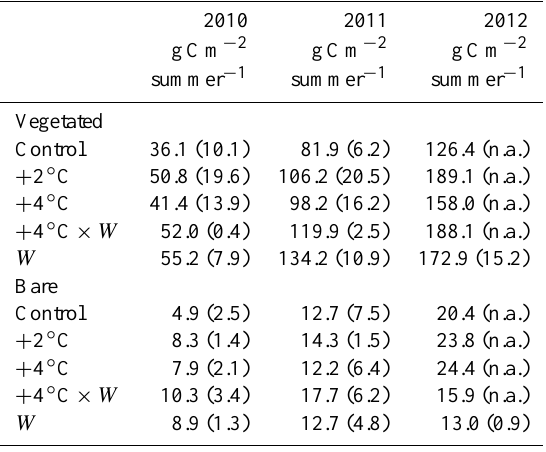
Table 3. Cumulative summertime R eco fluxes from high Arctic tun- dra in 2010–2012 under four treatments ( + 2 ◦ C, + 4 ◦ C, + 4 ◦ C × W and W ) and control (average ± SE (standard error), n = 1–3).